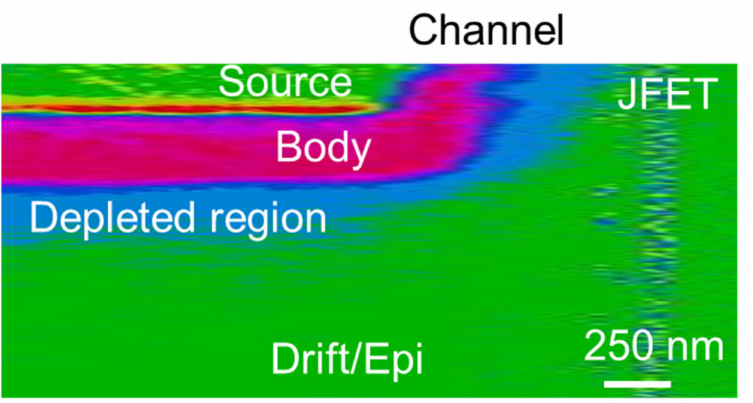
Figure 2. Cross section SCM image of the elementary MOSFET